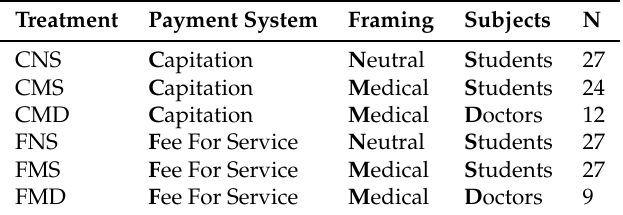
Table 6. Treatment overview.